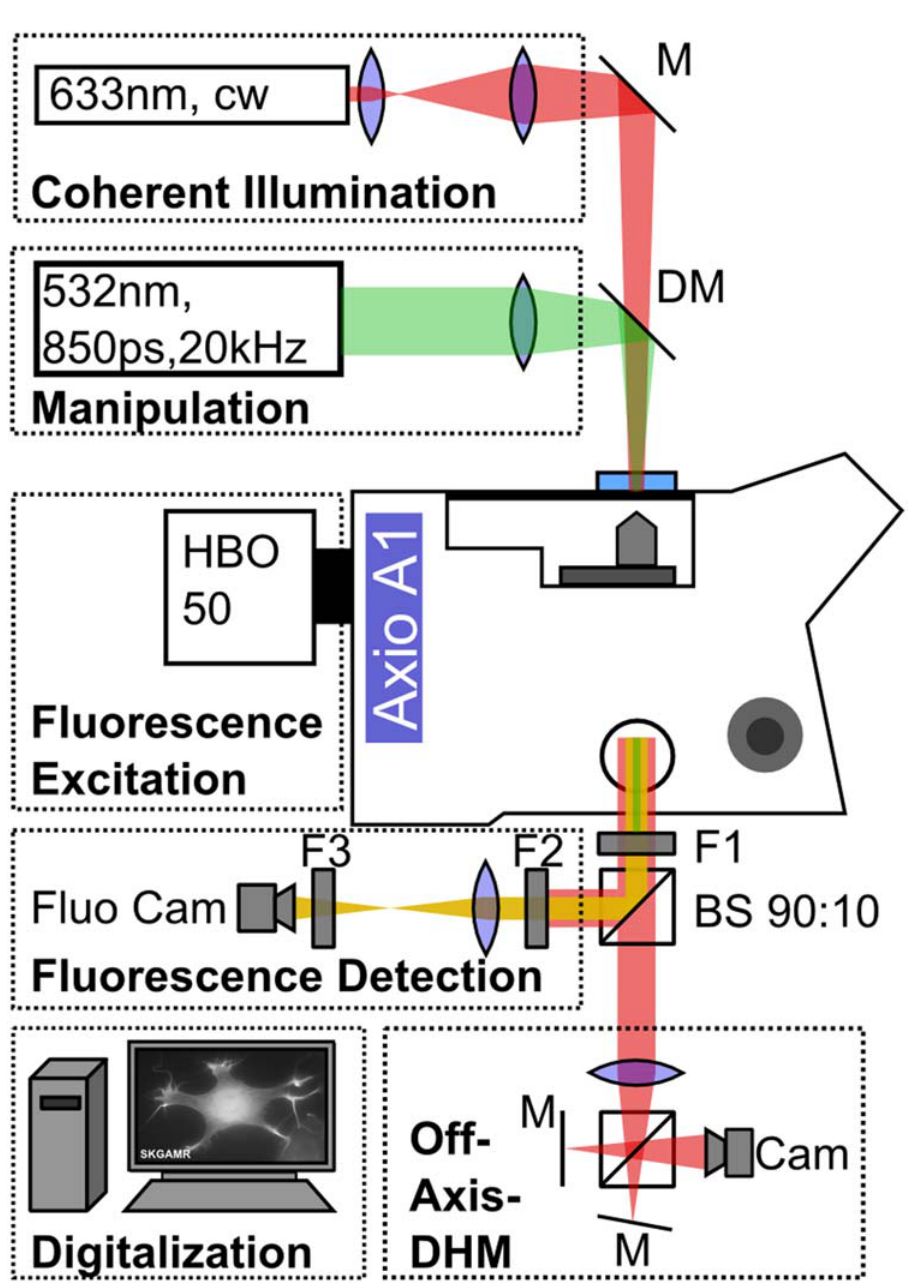
Fig 1. Schematic of the experimental setup. An epifluorescence microscope is modified to capture digital holography and fluorescence image data. Coherent illumination necessary for digital holography is realized by weakly focusing a cw Helium Neon Laser on the sample. The pulsed manipulation laser is coupled into the setup parallel to the HeNe-Laser using a dichroic mirror (DM) and focused onto the sample. For fluorescence excitation a mercury vapor lamp is employed. At the side port of the microscope the manipulation laser is attenuated using a notch filter (F1). A beam splitter directs 90% of the light to the fluorescence unit where it passes through a filter blocking the coherent illumination (F2) and an emission filter (F3). The remaining light travels to the digital holography module which is set up in off-axis Michelson configuration.